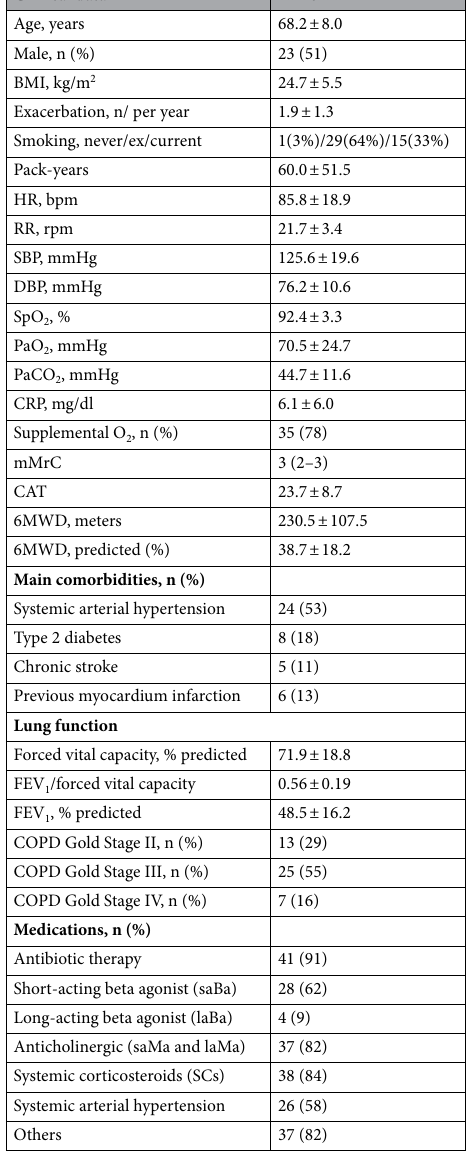
Table 1. Baseline patients’ features. Data are presented as mean ± SD or median (interquartile). BMI body mass index; HR heart rate; RR respiratory rate; SBP systolic brachial pressure; DBP Diastolic Brachial Pressure; sPO 2 oxygen saturation; PaO 2 partial pressure of oxygen; PaCO 2 partial pressure of carbon dioxide; CRP C-reactive protein; mMrC modified Medical Research Council; CAT COPD Assessment Test; 6MWD six minute walking distance; FEV 1 forced expiratory volume in first second; laBa long-acting Beta2-Agonist; SCs systemic corticosteroids; laMa long-acting anticholinergics; saBa short-acting Beta2-agonist; saMa Short- acting